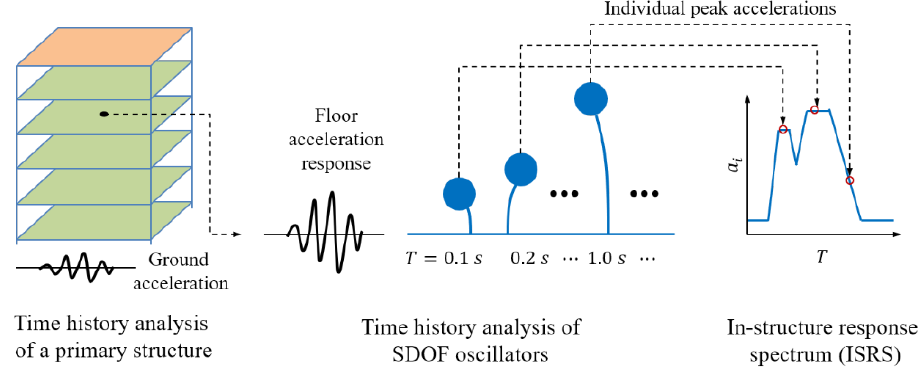
Figure 1. Procedure of calculating ISRS.